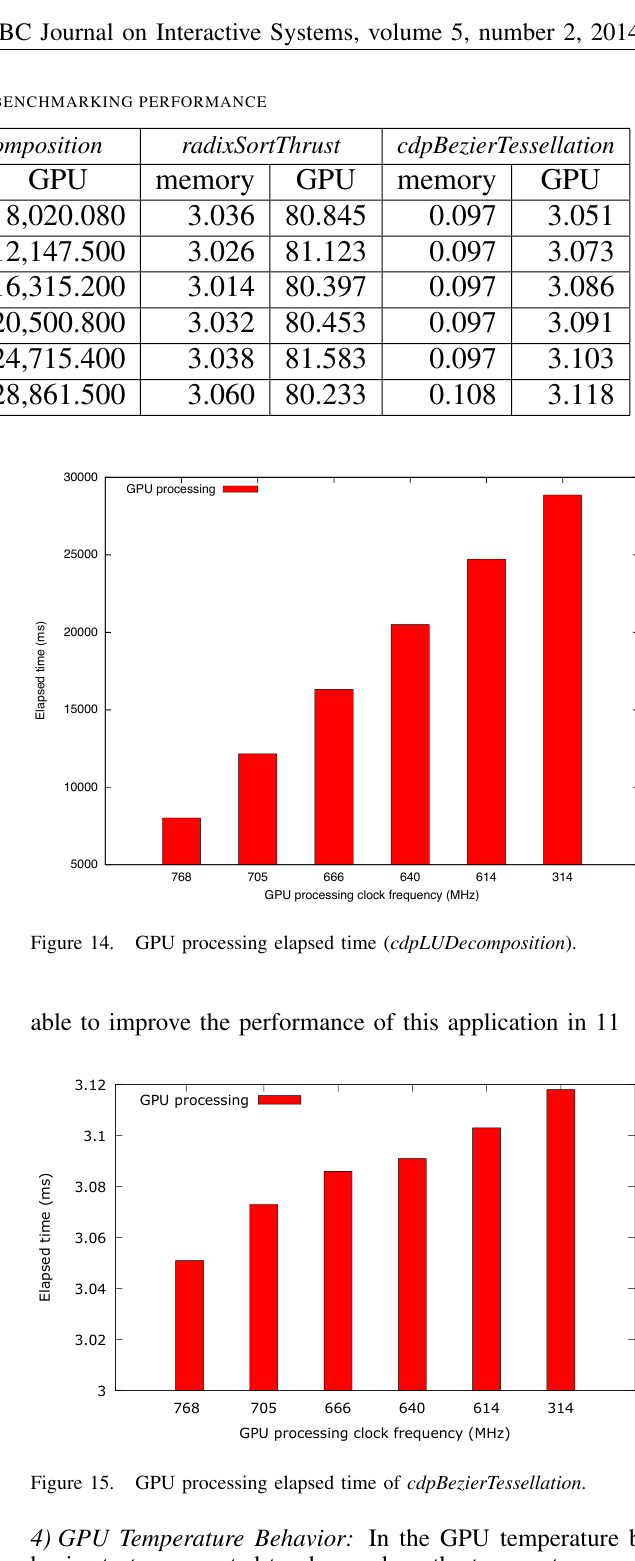
Figure 13. GPU processing elapsed time of cdpAdvancedQuicksort and radixSortThrust .